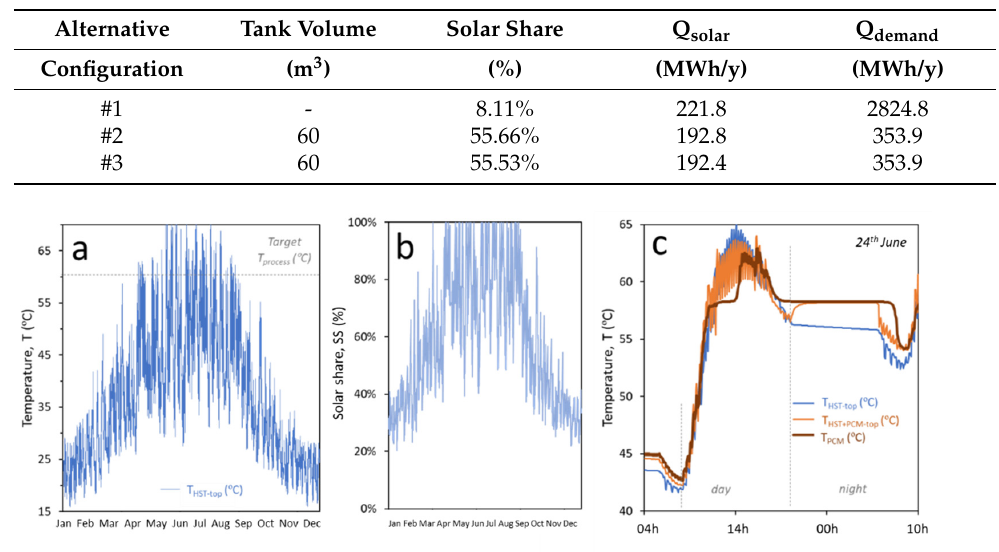
Table 4. Yearly average solar share and solar thermal energy production of the alternative configurations evaluated for the solar integration in the French charcuterie demo site.